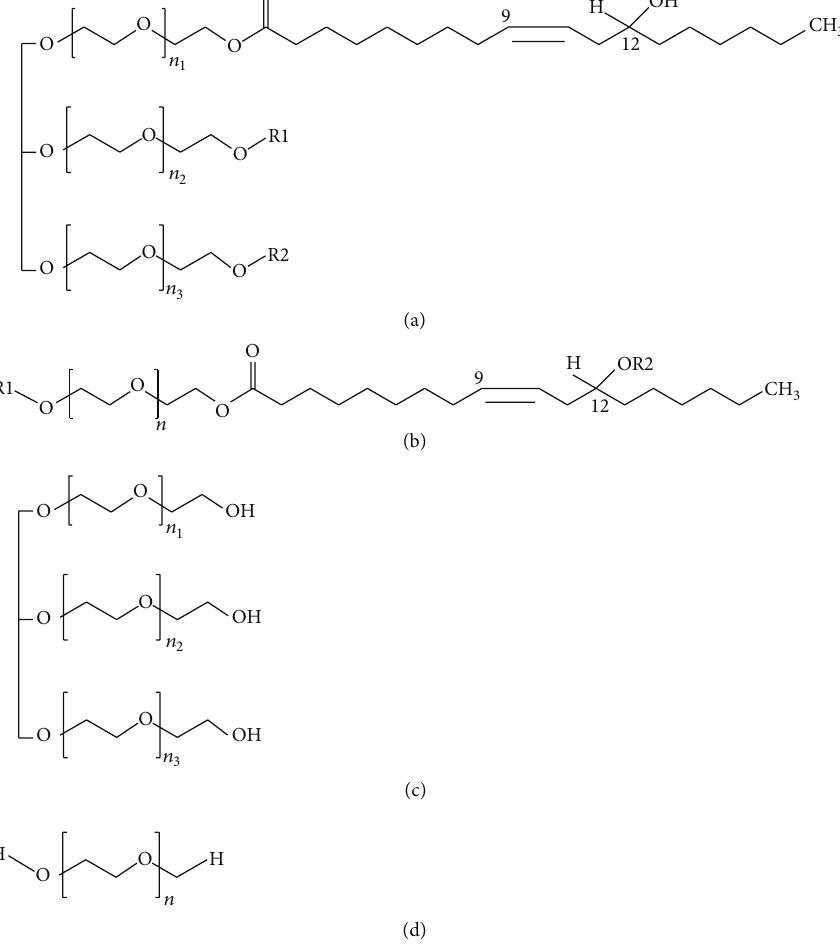
Figure 1: Components of CrEL according to [3]; hydrophobic portion consisting of (a) glycerol polyoxyethylene ricinoleate esters (R1, R2 corresponds to ricinoleic acid). (b) polyoxyethylene ricinoleate esters; hydrophilic portion consisting of (c) glycerol polyoxyethylene ether (d) free